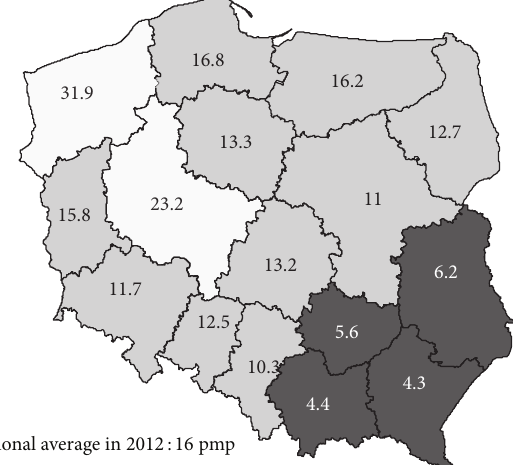
Figure 1: Average organ donations per million population per year across Poland in 2007–2012. HDR regions shown in white and LDR in